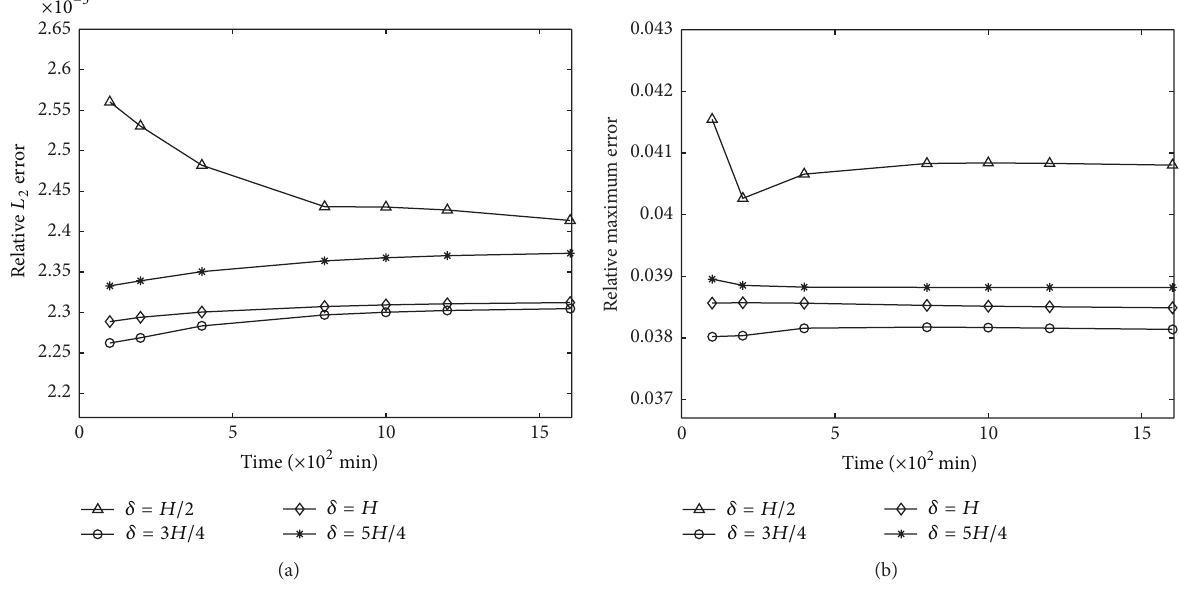
Figure17:Relative(a) 𝐿 2 and(b)maximumerrorsbetweenthefine-scalemodelandthenewschemeunderdifferentcellsizesforthetransient flow problem with weak well